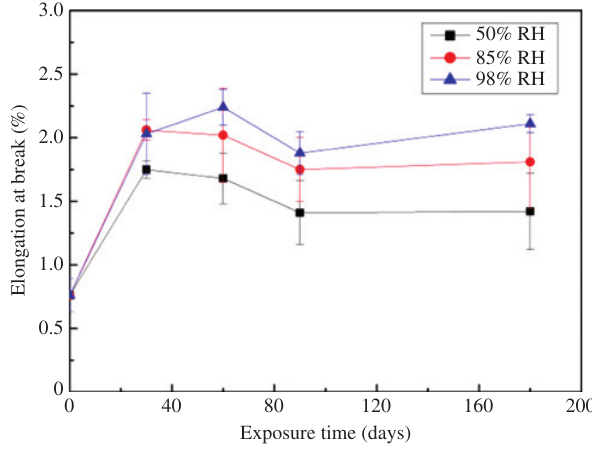
Figure 4 Variation of the tensile strength as a function of exposure time of ramie fiber fabric reinforced phenolic resin under three humidity conditions at room temperature.